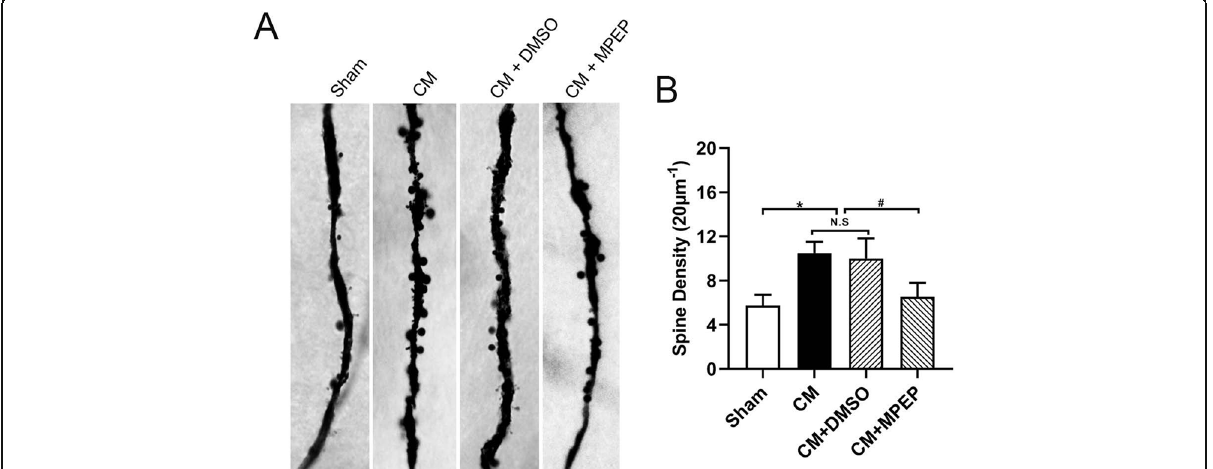
Fig. 6 Dendritic spine density of TNC neurons in each group. a Representative photos of dendritic spines in each group. b Compared with the sham group, the density of dendritic spines in the CM group significantly increased, and there were no significant differences between the CM and CM + DMSO groups. The administration MPEP significantly reduced the density of dendritic spines. (n = 4 in each group,scale bar = 5 μ m; *p < 0.05 compared with the sham group; # p < 0.05 compared with the CM + DMSO group; N. S:p > 0.05 between two groups)